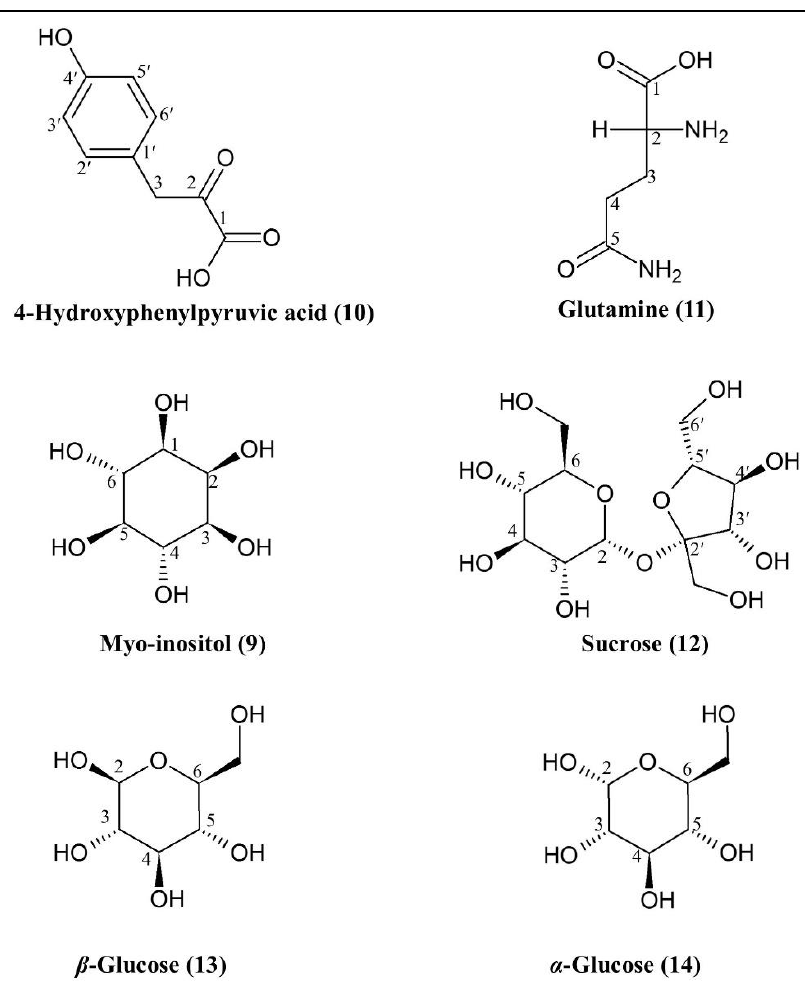
Figure 7. Chemical structures of putative metabolites identified by NMR-based metabolomics.